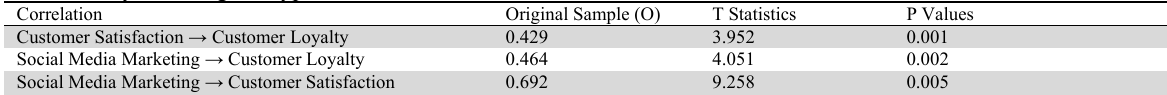
The summary of testing the hypotheses